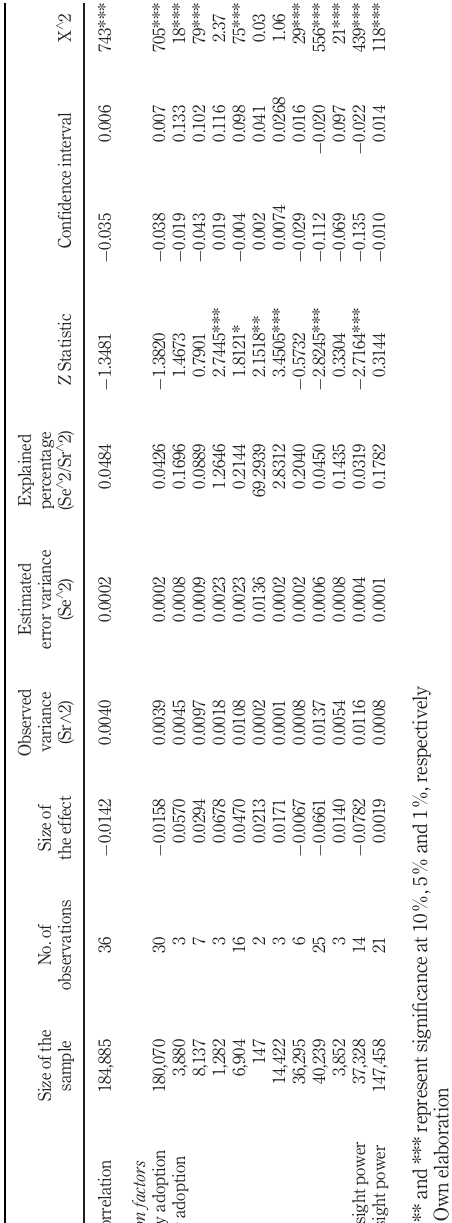
Table 1. Results of meta-